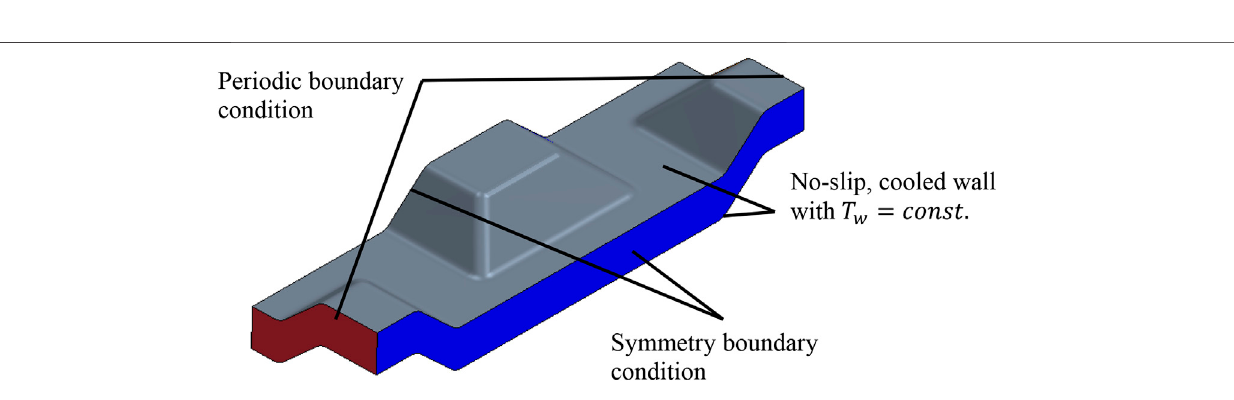
FIGURE 9 | Model of a representative channel